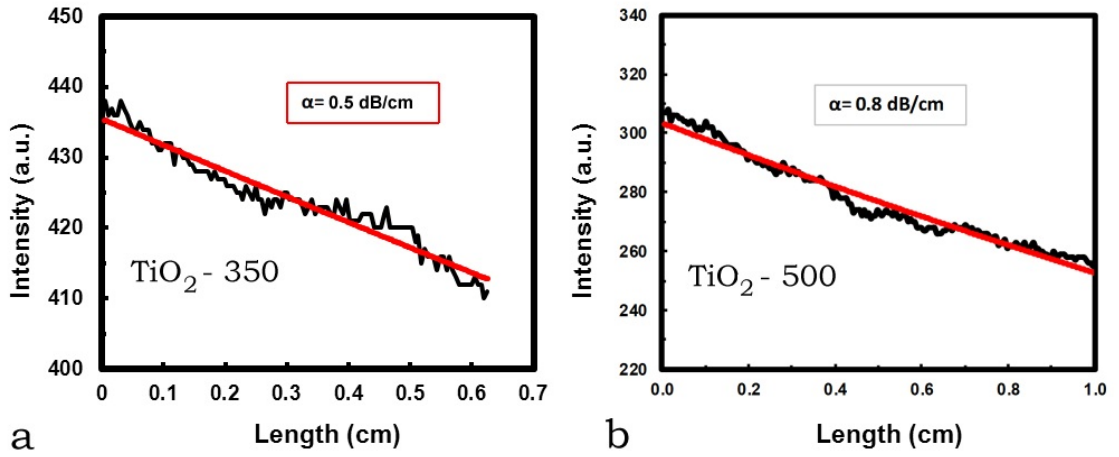
Figure 6. Optical attenuation of the fundamental TE mode in TiO -500 samples: surface scattering measurement (dotted line), with exponential fit and ( b ) TiO 2 (in red).